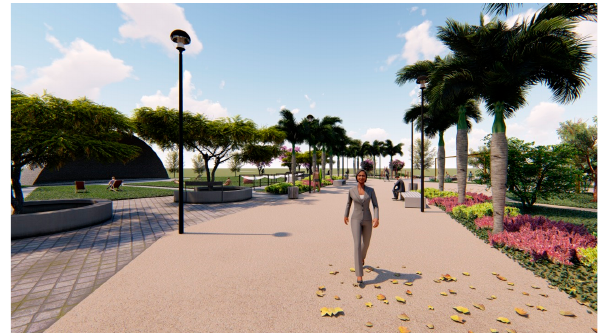
Figure 13. Main path on permeable pavement.